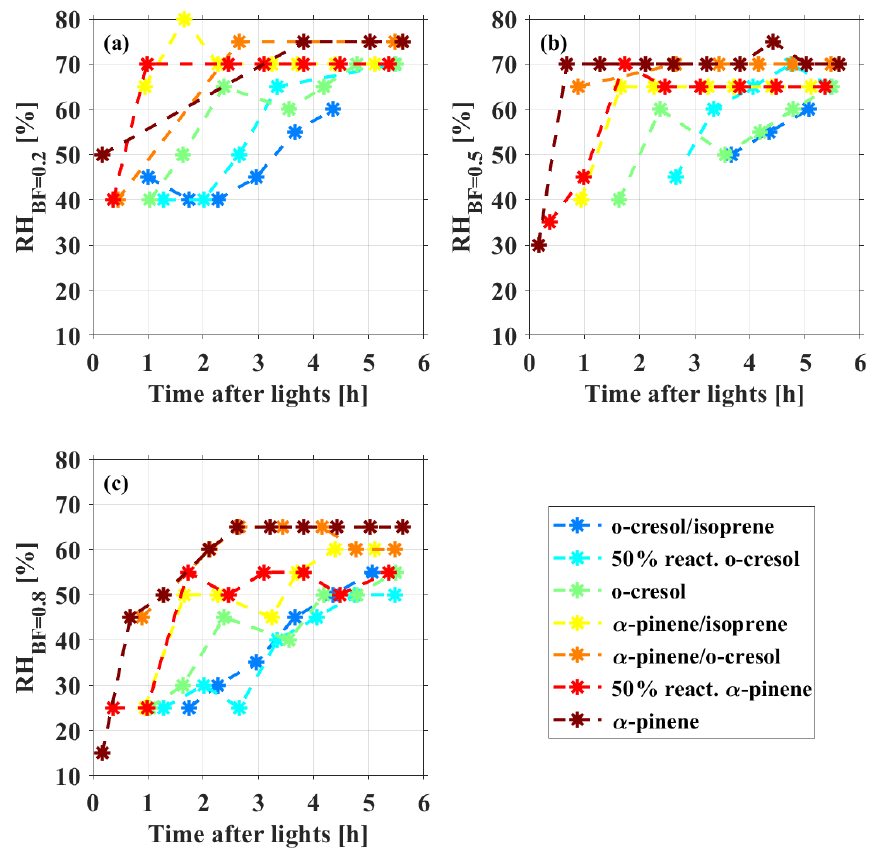
Figure 4. The time series of measured (a) RH BF = 0 . 2 , (b) RH BF = 0 . 5 , and (c) RH BF = 0 . 8 of the multicomponent aerosol particles in the photochemistry of various VOC systems on deliquescent ammonium sulfate